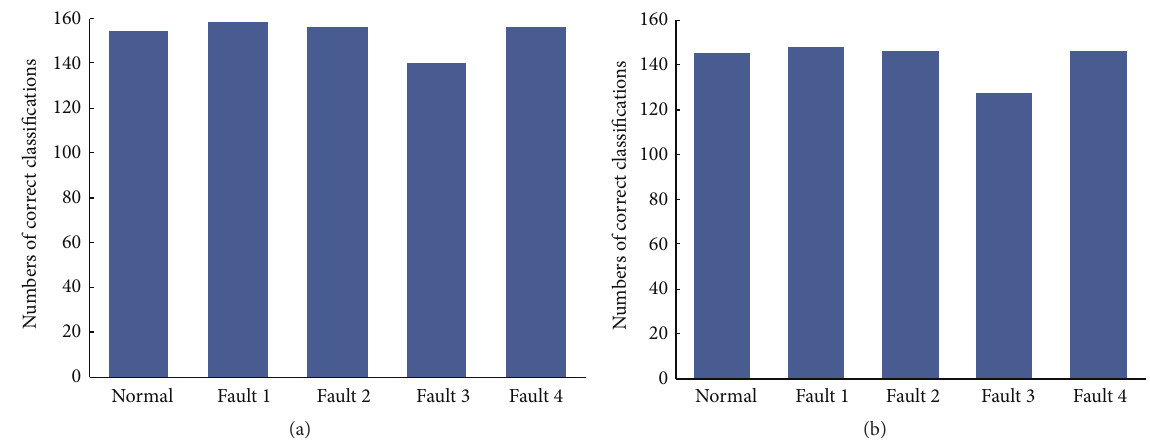
Figure 14: (a) Fault diagnosis result of ELM based on EURF. (b) Fault diagnosis result of ELM based on EMD.